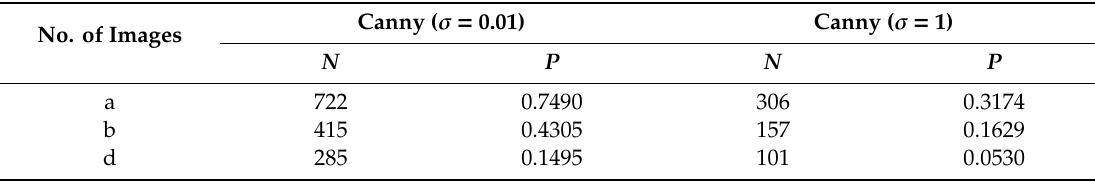
Table 2. Evaluations of fusion e ff ects in Figure 4.